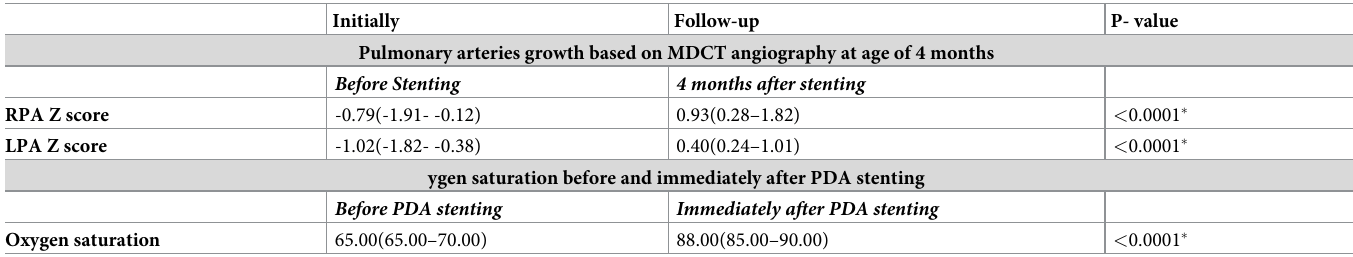
ygen saturation before and immediately after PDA stenting Before PDA stenting Immediately after PDA